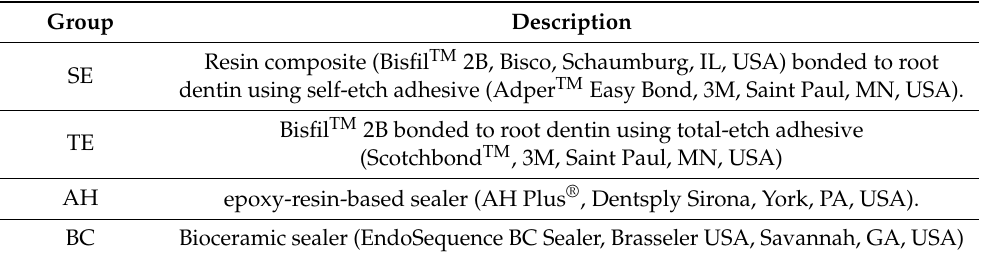
Table 1. Description of the materials used as sealers in the experimental